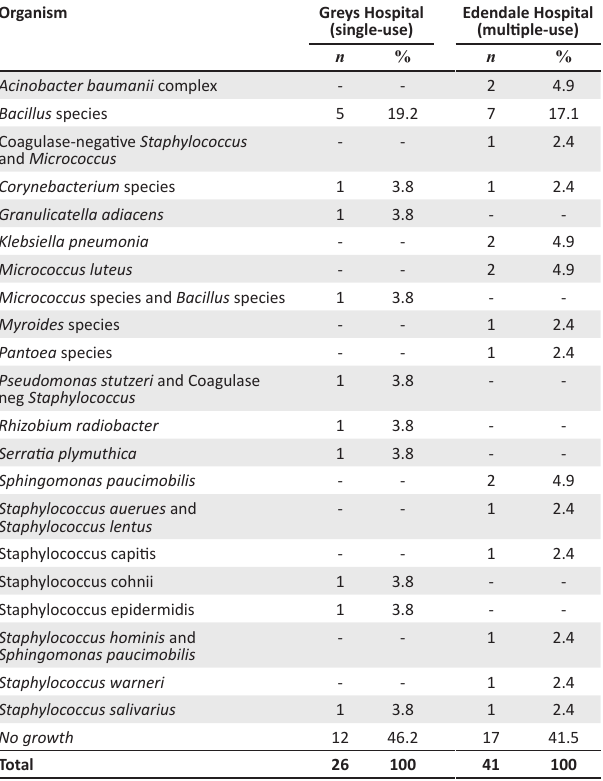
TABLE 1: Organisms cultured per study site. Organism Greys Hospital